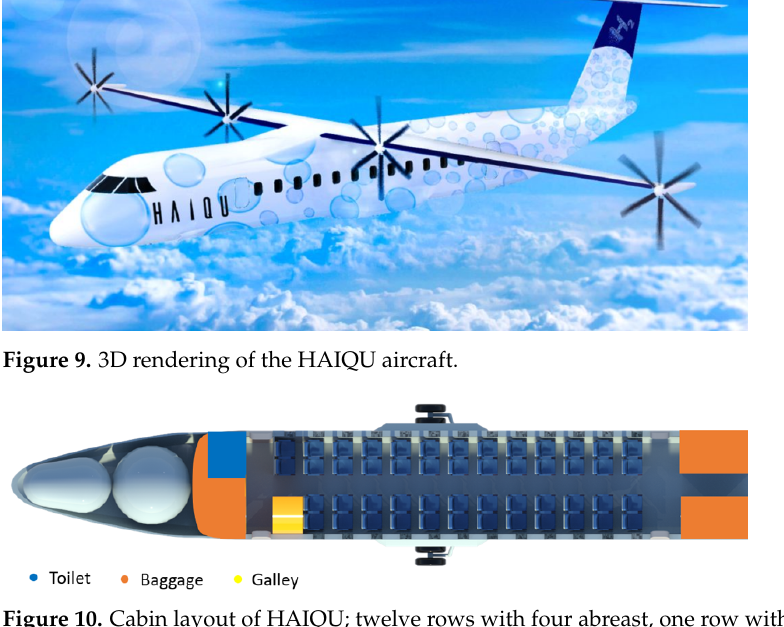
Figure 10. Cabin layout of HAIQU; twelve rows with four abreast, one row with two seats, space for baggage in the front and back and fuel tanks located behind the rear